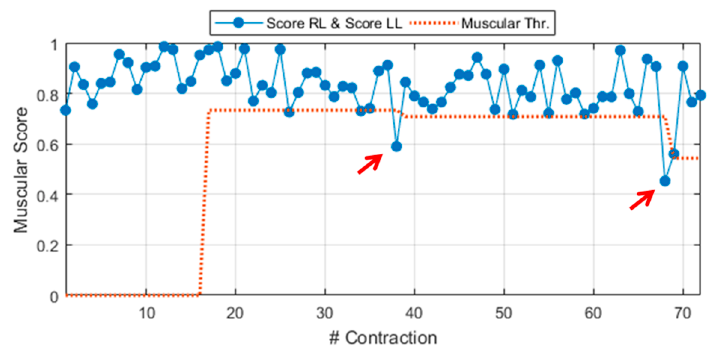
Figure 3. General muscular score (score right leg (RL) ∧ score left leg (LL)) during experimental walking to slip test (Sub. 3 – Trial 4).